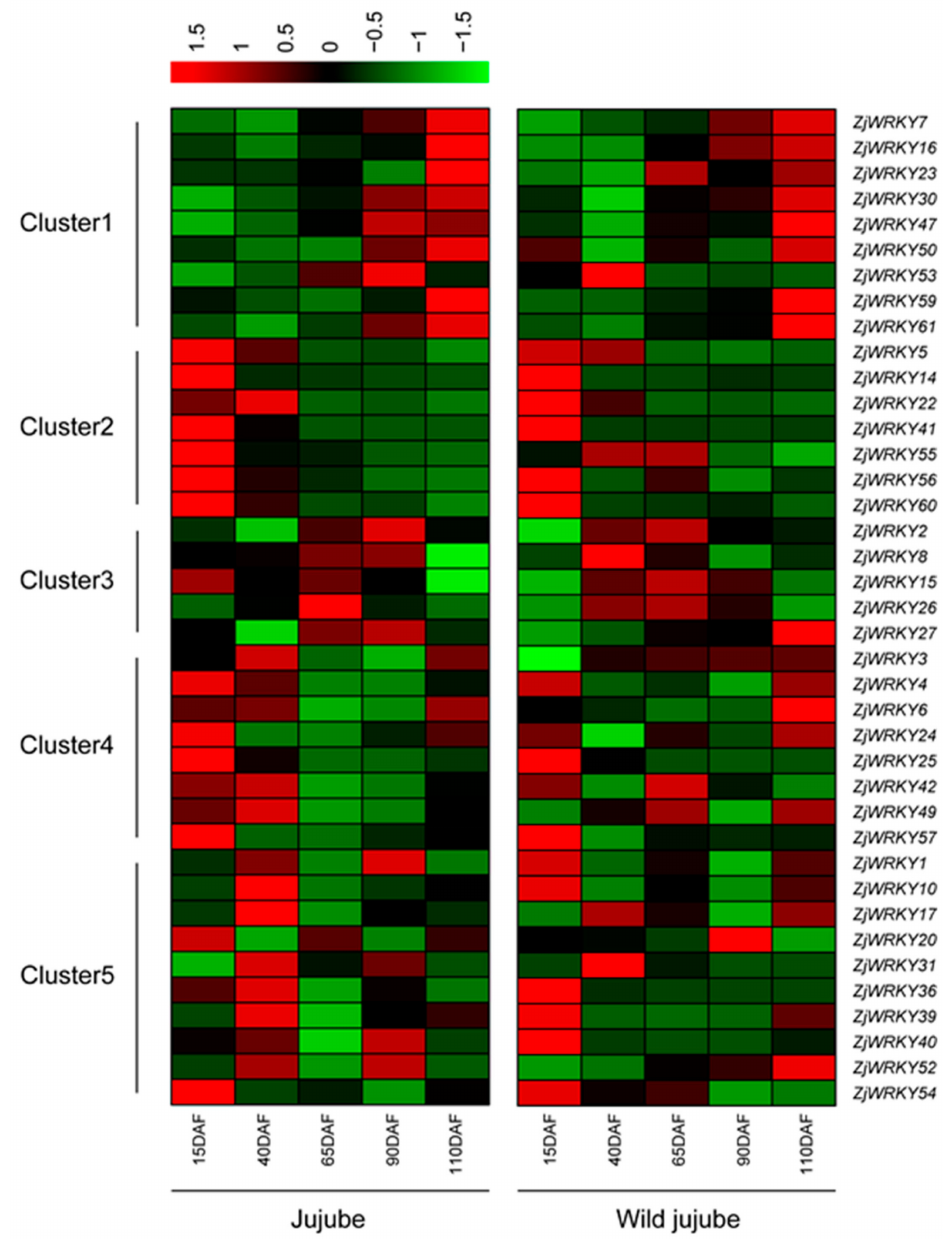
Figure 7. Transcriptional abundance of ZjWRKY genes during fruit ripening of cultivated jujube (‘Junzao’) and wild jujube (‘Qingjiansuanzao’). RPKM was used to measure the expression levels of the ZjWRKY genes. Red denotes high expression levels, and green denotes low expression levels. Clustering was done according to the expression level of ZjWRKY genes in jujube